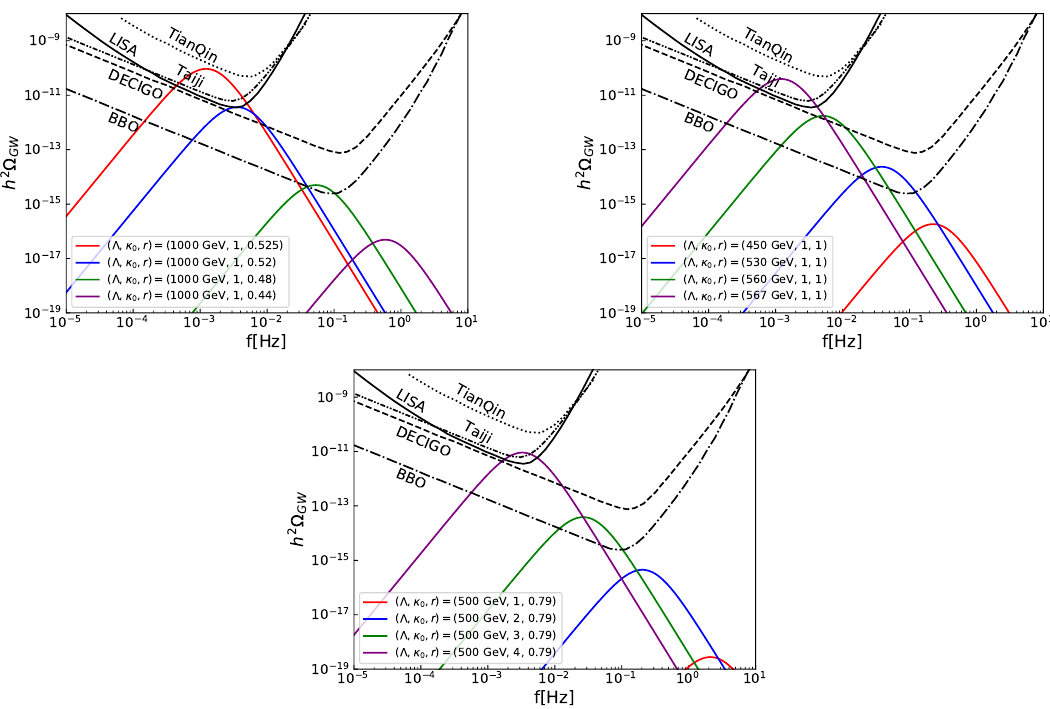
Figure 5 . The GW spectra for some benchmark